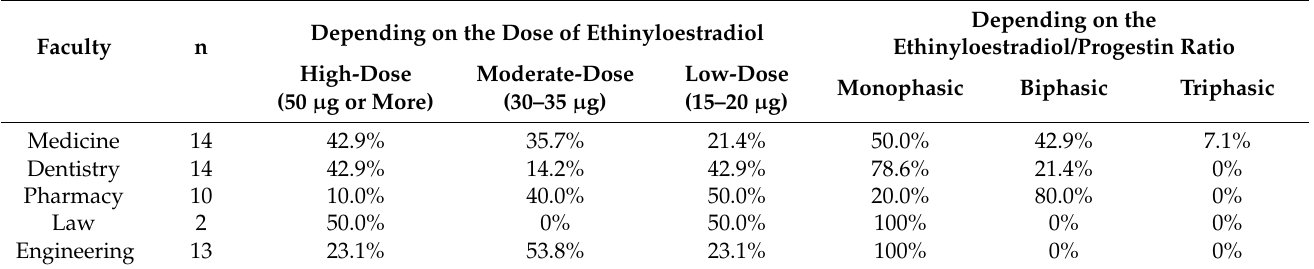
Table 3. Preference for the type of oral contraceptive pill correlated with the